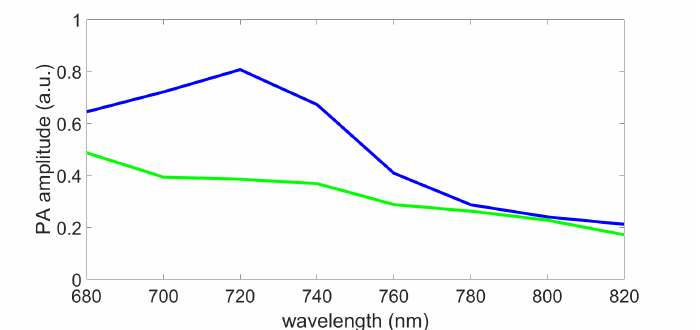
Figure 3. Spectra, measured with a Perkin Elmer Lambda900 spectrometer for the study [28], of the blue and green inks used to make the phantoms (a.u., arbitrary